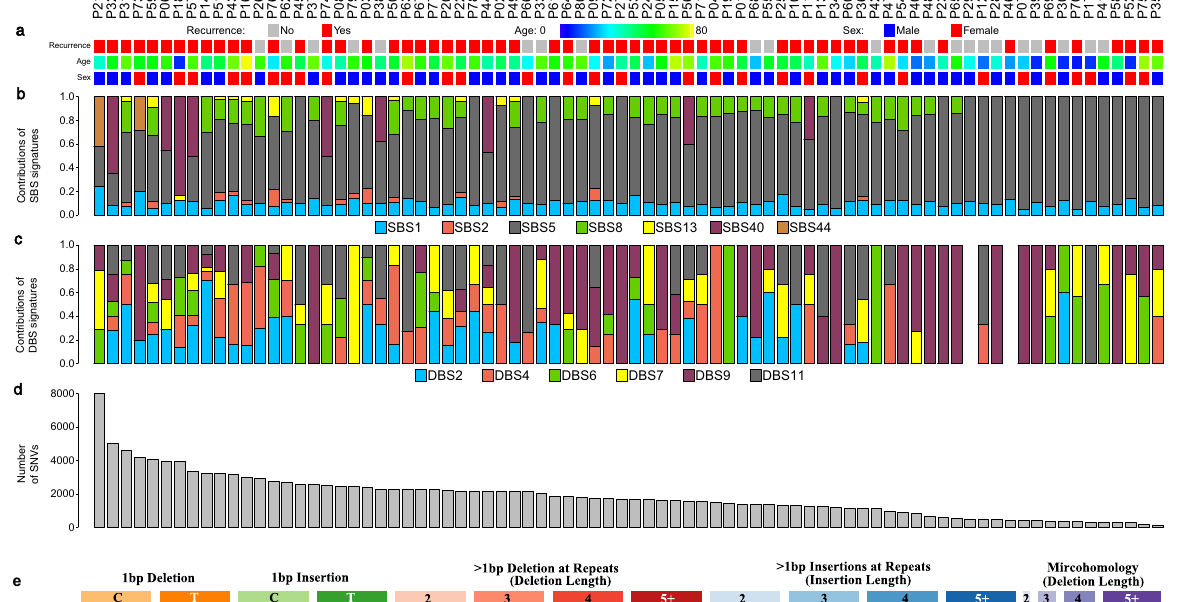
deletions. Group 4 ( n = 19) had no or few SCNAs. Group 5 ( n = 7) was characterized by the enrichment for extensive chromo- some gains throughout the genome (Fig. 3a), a characteristic consistent with whole-genome doubling (WGD), de fi ned by 50% of autosomal genome having an MCN (the more frequent allele in a given segment) greater than or equal to two (Supplementary